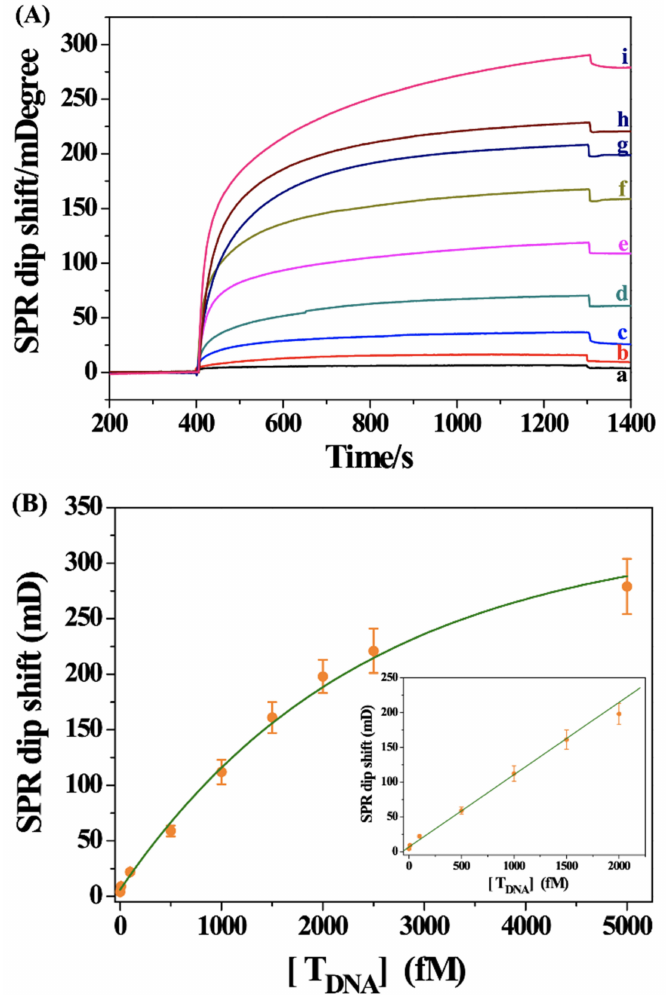
Figure 2. ( A ) SPR sensorgrams for the detection of different concentrations of T DNA (a~i: 1, 10, 100, 500, 1000, 1500, 2000, 2500 and 5000 fM). ( B ) Dependence of SPR signal on T DNA concentration. The inset shows the linear portion of the fitting curve.